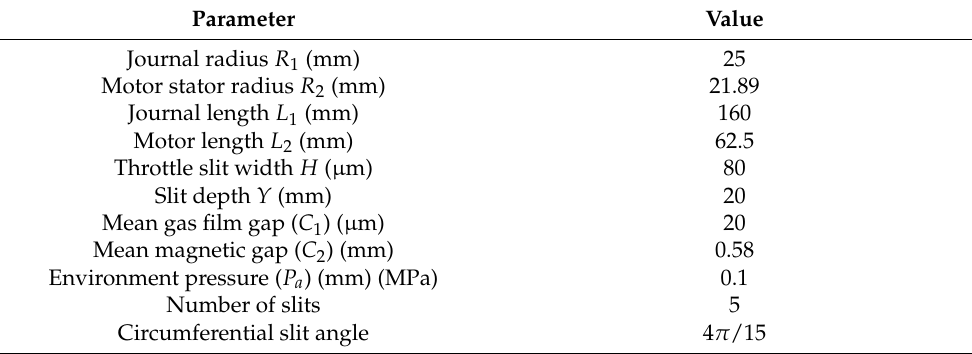
Table 1. Structural parameters of motorized spindle.